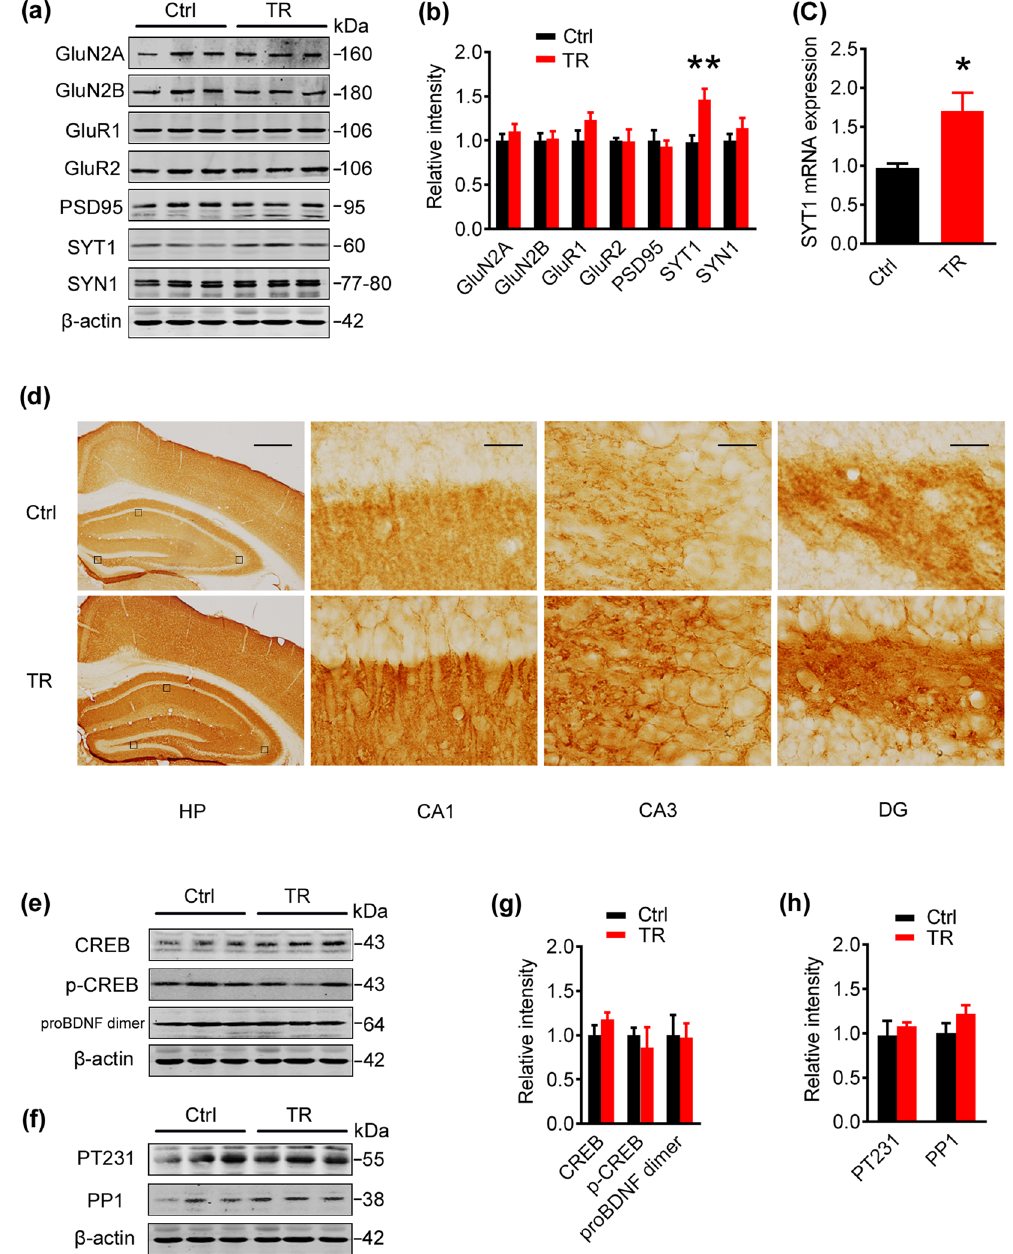
Figure 2. Father’s spatial training increases synaptotagmin 1 in 129s F1 offspring. ( a,b ) Father’s spatial training increased protein level of SYT1 in 7-m 129s F1 offspring measured by Western blotting. ( c ) Father’s spatial training increased mRNA level of SYT1 in 7-m 129s F1 offspring measured by quantitative RT–PCR. Bar graphs show mean ± SEM ( * p < 0.05, two-tail t-test, n = 5~6 per group). ( d ) Immunohistochemical staining of SYT1 in cortex and hippocampus of 7-m 129s F1 brain slices. The HP (hippocampus) panel: scale bar = 50 μ m; the enlarged CA1 (cornu ammonis 1), CA3 (cornu ammonis 3) and DG (dentate gyrus): scale bar = 2 μ m. ( e,g ) Expression level of CREB, p-CREB and proBDNF dimer in 7-m 129s F1 offspring measured by Western blotting. ( f,h ) Levels of phosphorylated tau (PT231) and protein phosphatase-1 (PP1) in 7-m 129s F1 offspring measured by Western blotting. ( a,b,e–h ) The blot images were cropped to display and quantitifed by the Odyssey Infrared Imaging System (Licor biosciences, Lincoln, NE, USA). Bar graphs show mean ± SEM. ( ** p < 0.01, two-tail t-test, pre-synaptic SYT1: n = 6 per group; the rest of synapse- or memory-associated proteins: n = 3 per